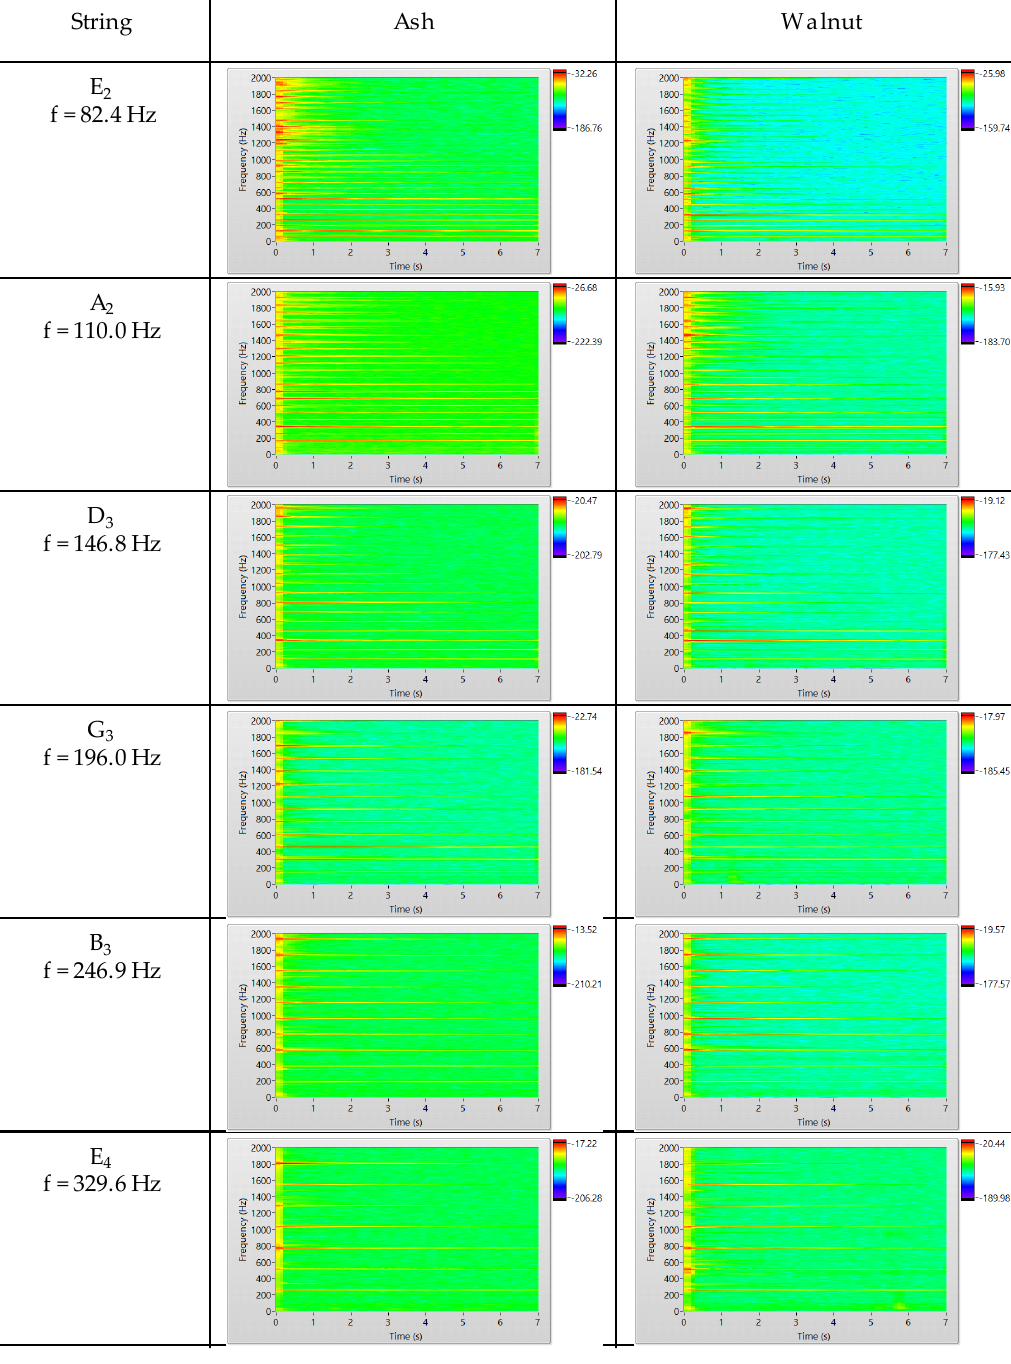
Figure 8. Short-Time Fourier Transformation (STFT) spectrograms of the vibrating strings (E 2 , A 2 , D 3 , G 3 , B 3 and E 4 ) of the guitar with the body made of ash wood (left) and with the body made of walnut wood (right).